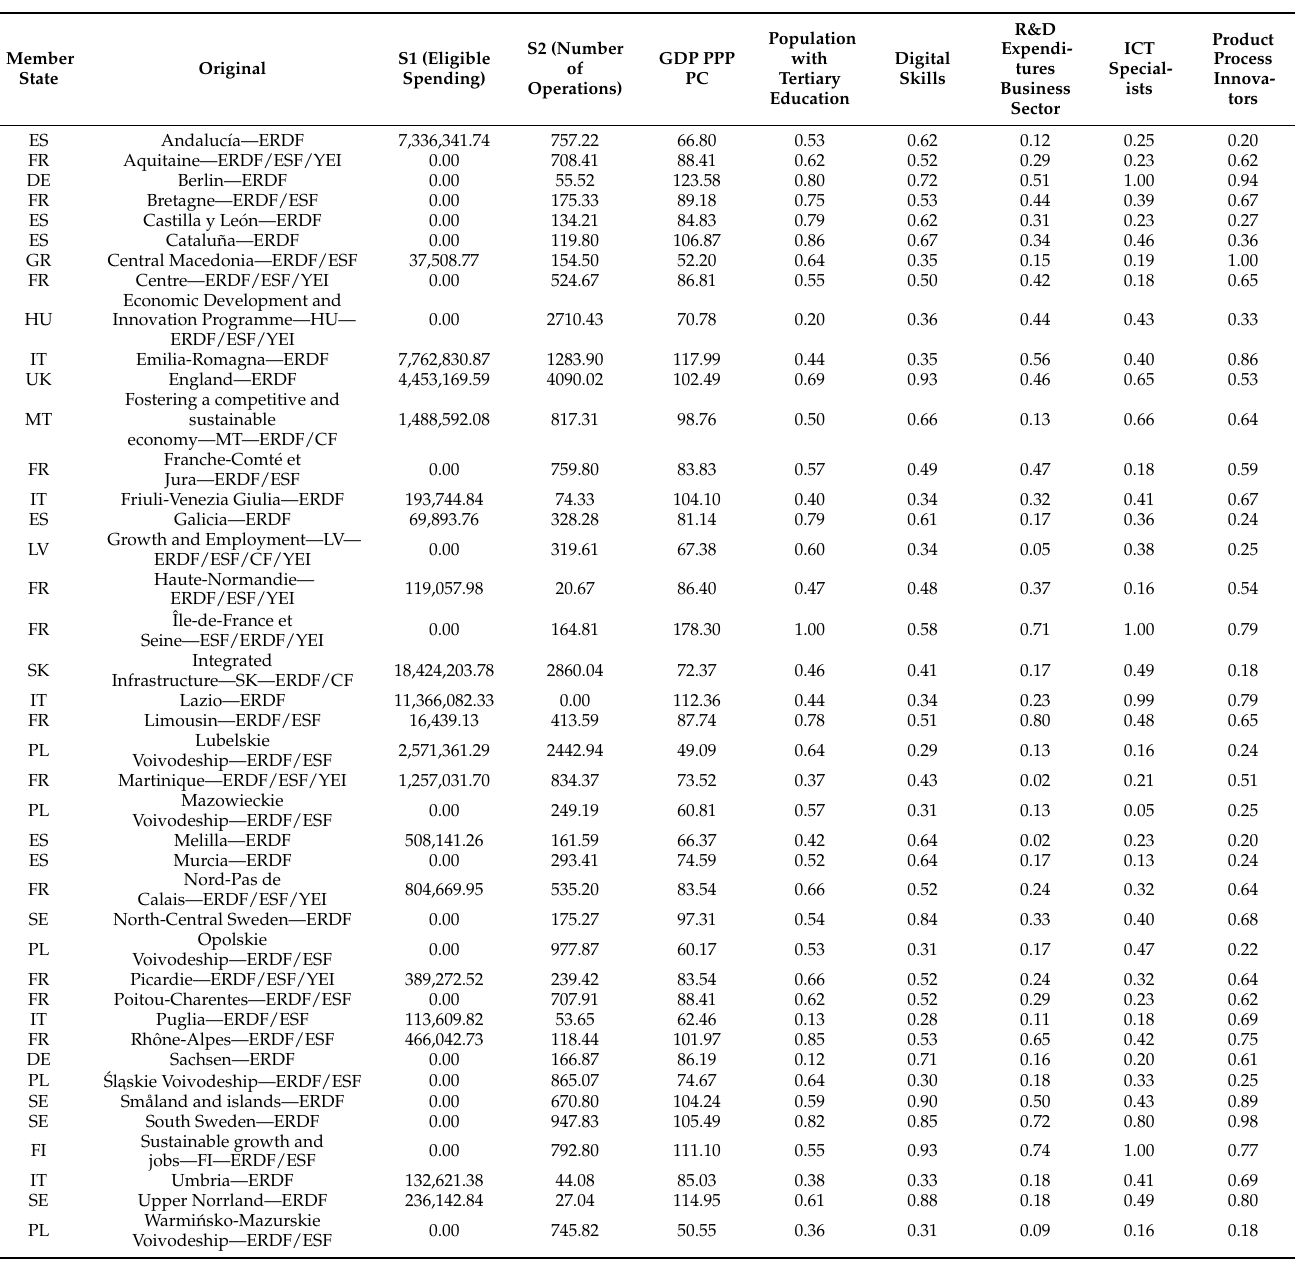
Table A3. Data on the environmental